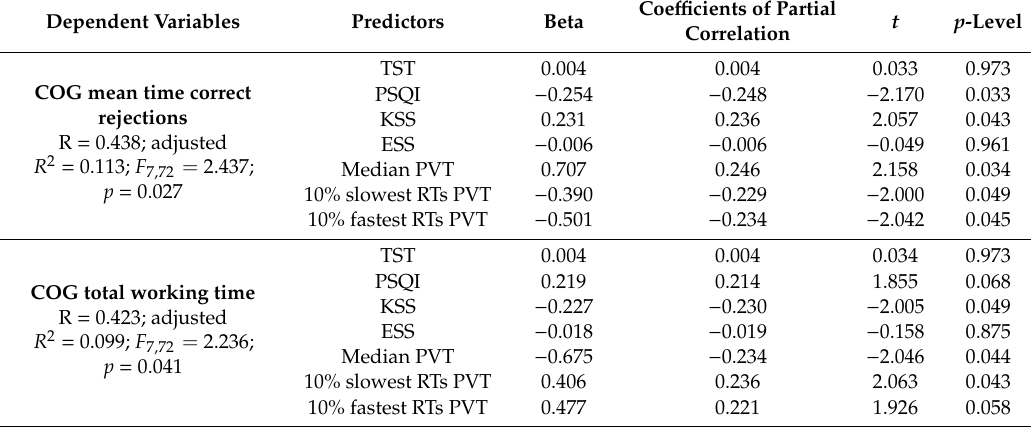
Table 4. Results of the multiple regression considering the performance and the working time in the selective attention test (COG mean time correct rejection and COG total work time) as criterion variable and TST, PSQI, KSS, ESS, Median PVT, 10% slowest RTs PVT, 10% fastest RTs PVT as predictors. After the correction for multiple comparisons by using FDR, the results do not remain statistically